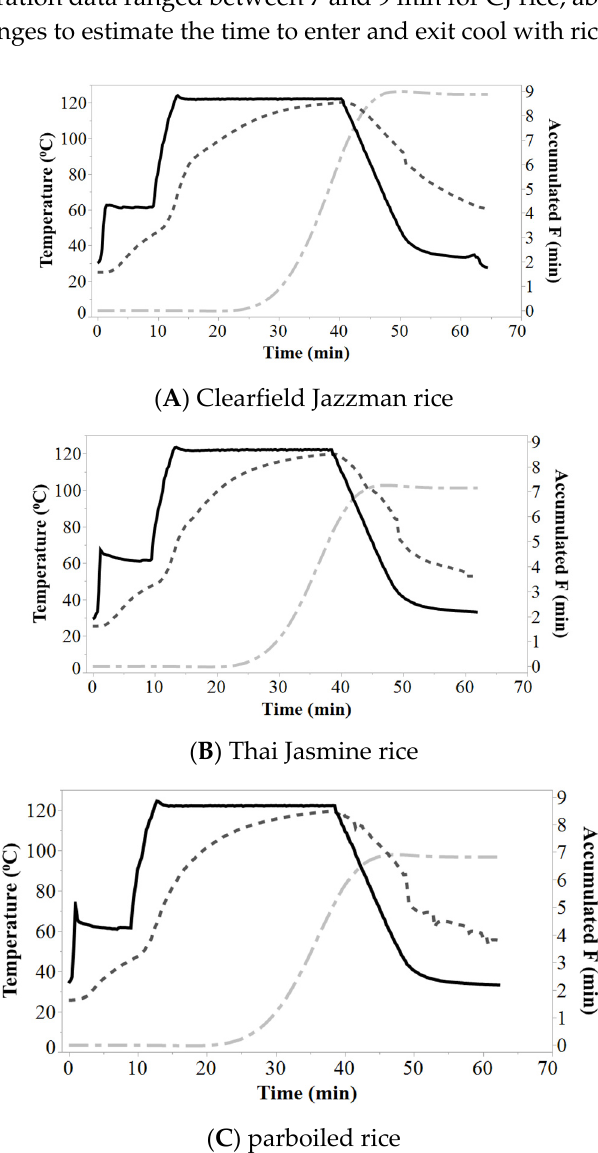
Figure 1. Clearfield Jazzman ( A ), Thai Jasmine ( B ), and parboiled ( C ) rice slowest heat penetration data at 0 SPM displaying retort temperature ( ), heat penetration ( ), and accumulated F 0 ( ). shakes per min (SPM).